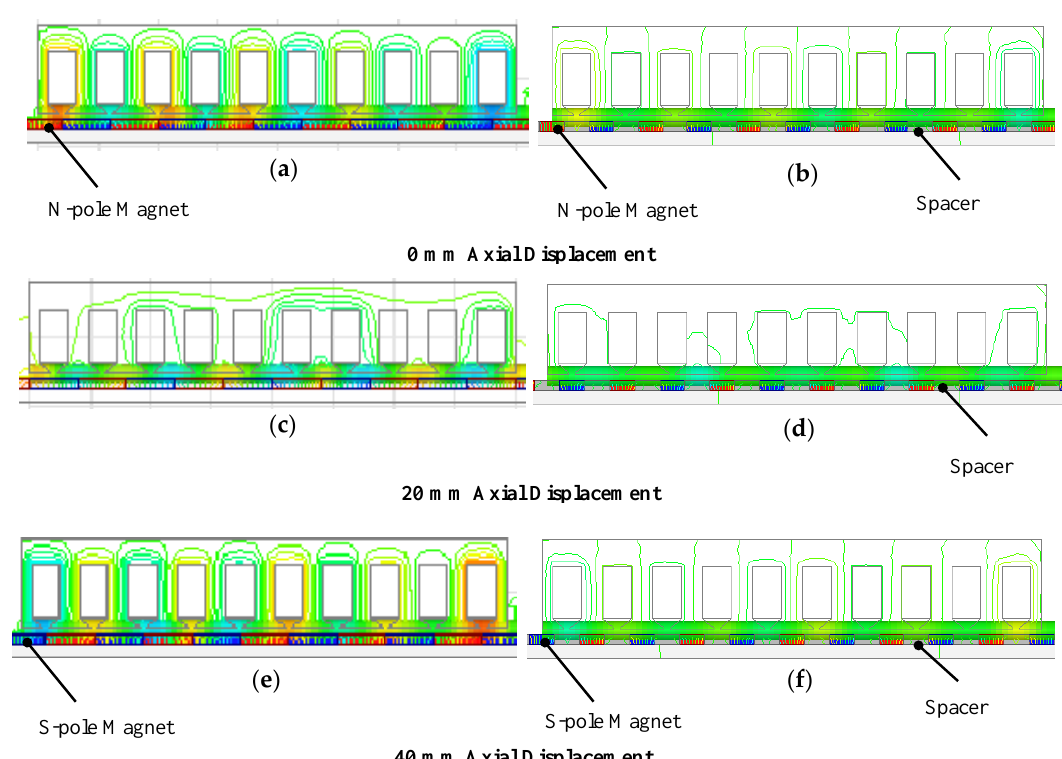
Figure 10. Open-circuit Flux Distribution of ( a ) Magnetization without Spacer Design at 0 mm Axial Displacement; ( b ) Magnetization with Spacer Design at 0 mm Axial Displacement; ( c ) Magnetization without Spacer Design at 20 mm Axial Displacement; ( d ) Magnetization with Spacer Design at 20 mm Axial Displacement; ( e ) Magnetization without Spacer Design at 40 mm Axial Displacement; ( f ) Magnetization with Spacer Design at 40 mm Axial Displacement.